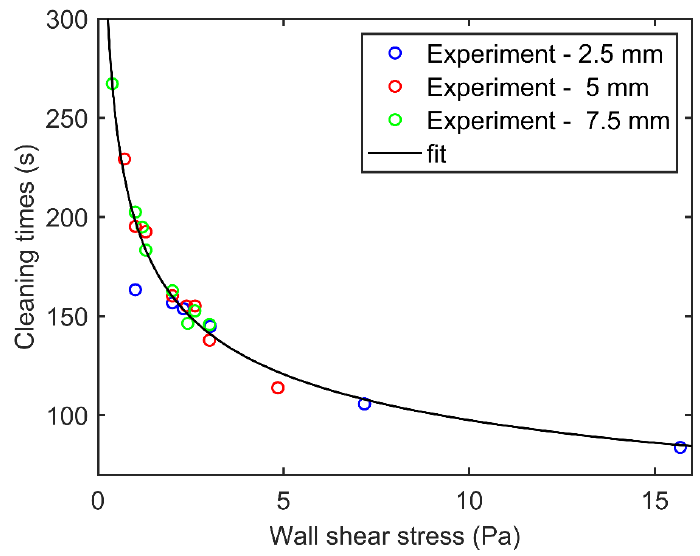
Figure 10. Cleaning times plotted against velocity.